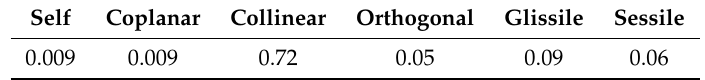
Table 1. Coefficients of interaction matrix Q ( αβ ) for body centered cubic (BCC)-Fe [51]. Self Coplanar Collinear Orthogonal Glissile